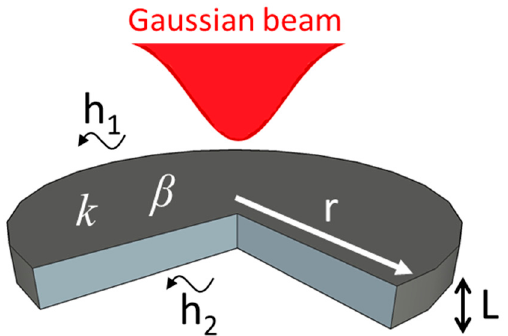
Figure 1. Schematic representation of a composite membrane showing the relevant parameters involved in the mathematical model describing light absorption and heat generation in PDMS/CNP composites (see text).